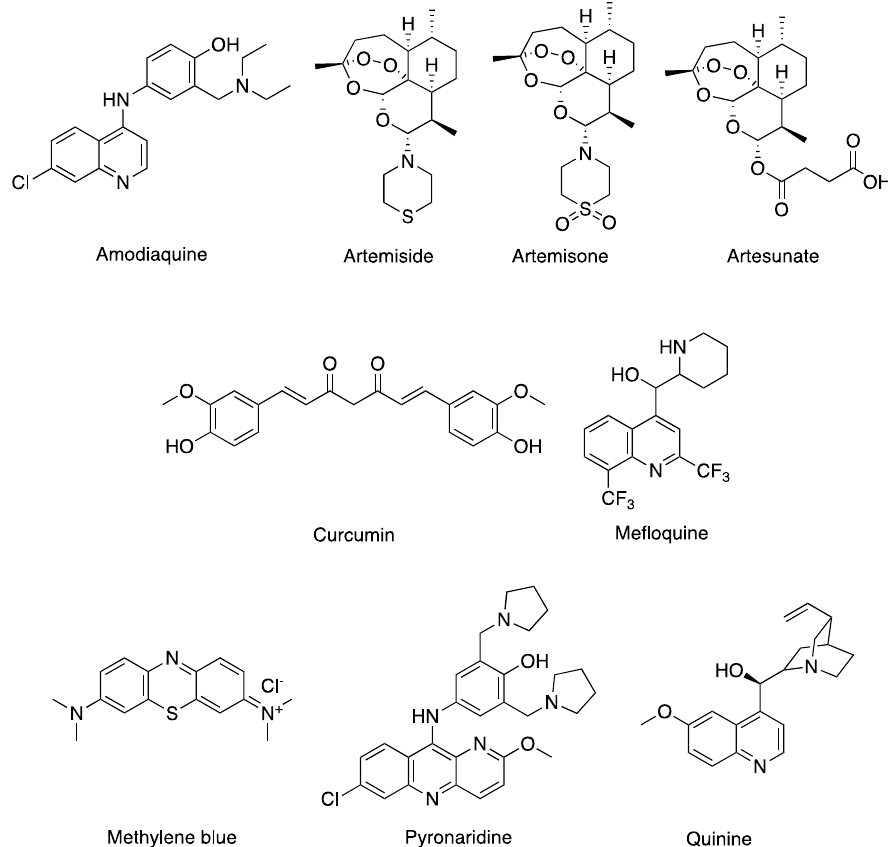
Figure 1. Structures of the antimalarial compounds used in this investigation.